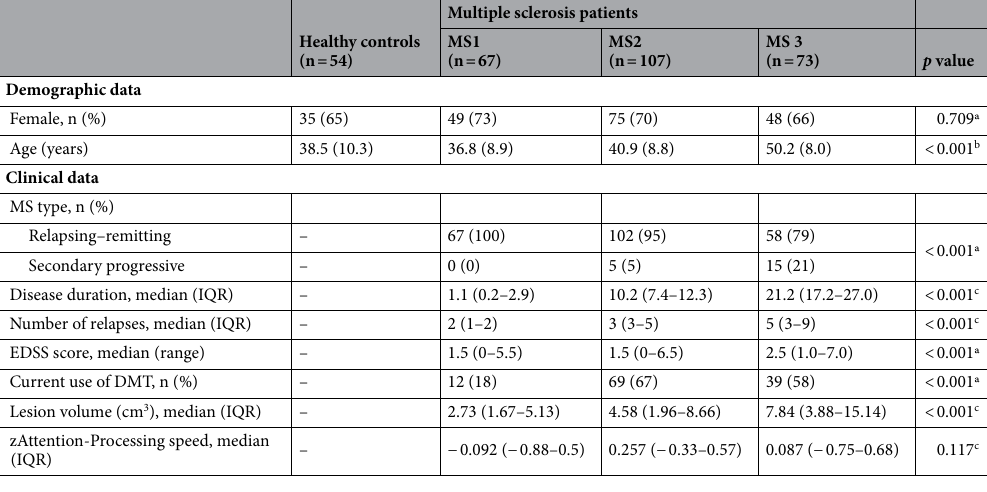
Table 1. Demographic, clinical, and cognitive data of the study population. Continuous variables are given as the mean (SD). DMT, Disease Modifying Treatment; EDSS, Expanded Disfigability Status Scale; IQR, Interquartile range; MS, multiple sclerosis. ªChi-squared test. b One-way Anova test; c Kruskal–Wallis